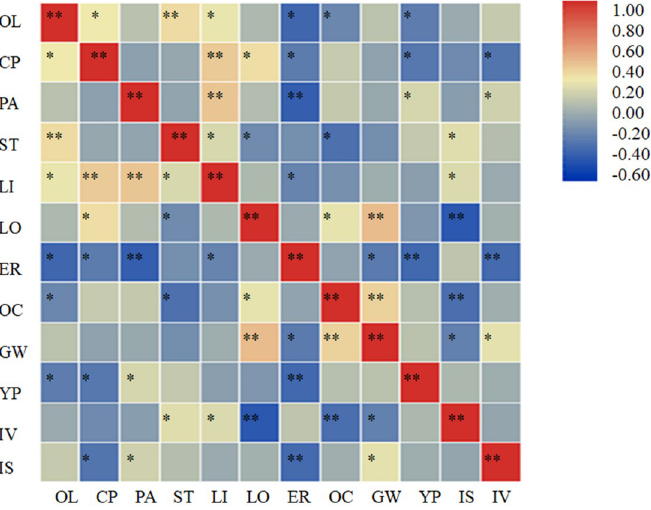
Fig 2. Correlation analyses of traits of different high-oleic rape